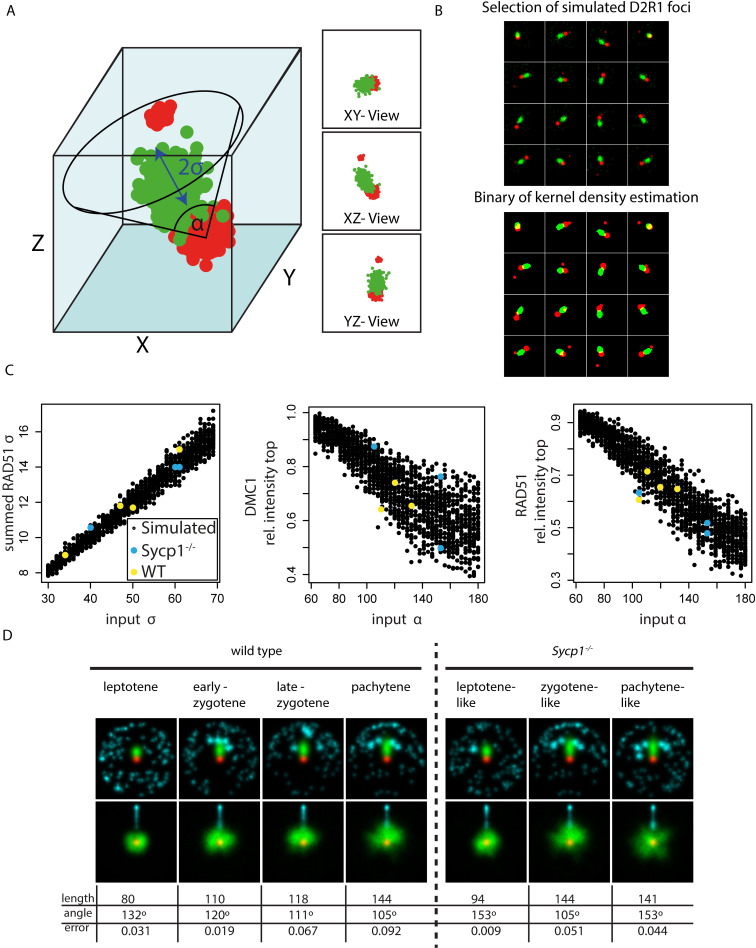
Simulations of D2R1 rotations.A) Model of D2R1 foci in three dimensions, where the alpha indicates the maximum angle relative to the DMC1-DMC1 axis, and the sigma the length of the major axis of the RAD51 nanofocus. B) Selection of simulated foci using one model randomly positioned in space and visualised in two dimensions (top), and corresponding binaries of kernel density estimation (bottom). C) Measured RAD51 length in summed 2D images (left), DMC1 intensity in the top half (middle), and RAD51 intensity in the top quadrant for all simulated foci (right), where each point represents an assembly from 200 aligned foci, and RAD51 was rotated above the center in the left and middle graph, and the far DMC1 was rotated in the right graph. Coloured points represent measured values from experimental data from both wild type (yellow) and Sycp1-/- (blue) nuclei at the stages analysed. D) Summed images (top; RAD51 rotation, bottom; far DMC1 rotation) of simulations that fit best to experimental data, length (full width half maximum: 2.355σ), angle and error are indicated.